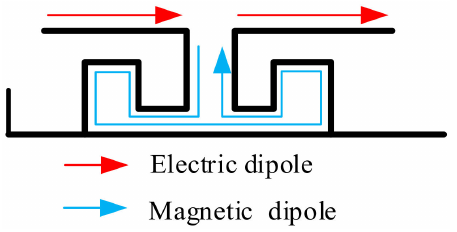
Figure 4. The schematic diagram of electric dipole and magnetic